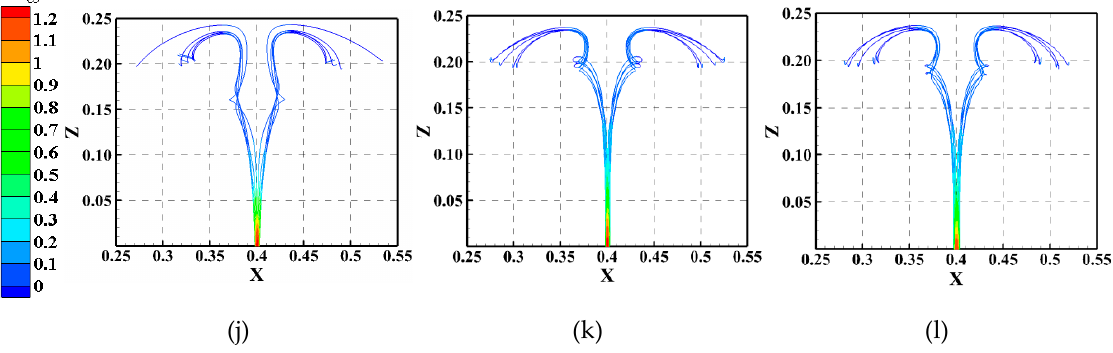
Figure 7. Variations of streamtraces under different cases: ( a ) case 1, ( b ) case 5, ( c ) case 9, ( d ) case 2, ( e ) case 6, ( f ) case 10, ( g ) case 3, ( h ) case 7, ( i ) case 11, ( j ) case 4, ( k ) case 8, ( l ) case 12.